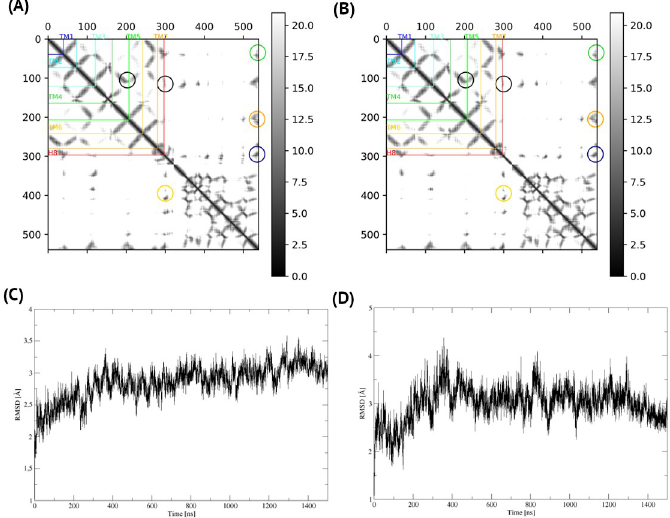
Fig 2. A homology model vs. a microsecond MD-refined model–C5aR1 with G i . The homology model of active C5aR1 and G i subunits based on the FPR2 template (A) did not change significantly during microsecond MD simulations (B) which confirmed its reliability. Here, contact maps were shown with the 20 Å cutoff for C α -C α distances and the joined, C5aR1 and G α , sequence numbering. G β and G γ subunits were excluded for the sake of clarity. The C5aR1 –G α interactions in the C5aR1 C-terminus–G α –G β triple interface (yellow circles) were kept stable (compare A and B). Interactions between C5aR1 and G α not involving G β (green, orange, dark blue circles) also remained the same, similarly to the internal receptor contacts (black circles: left–TM3-TM5 right–ICL2 –C-terminus). The only visible difference was in the receptor sequence region just after H8 (an unstructured, flexible C-terminus) that was adjusted to interact with G α . A corresponding gradient contact map for the whole simulation trajectory was included as S2 Appendix. (C) The receptor TM core, after a quick adjustment to the lipid bilayer during first 20 ns, remained the same within 3 Å RMSD compared to the starting homology model. The N-terminal part of TM7 and H8 (D) also adjusted during first few ns with the final RMSD not exceeding 3 Å